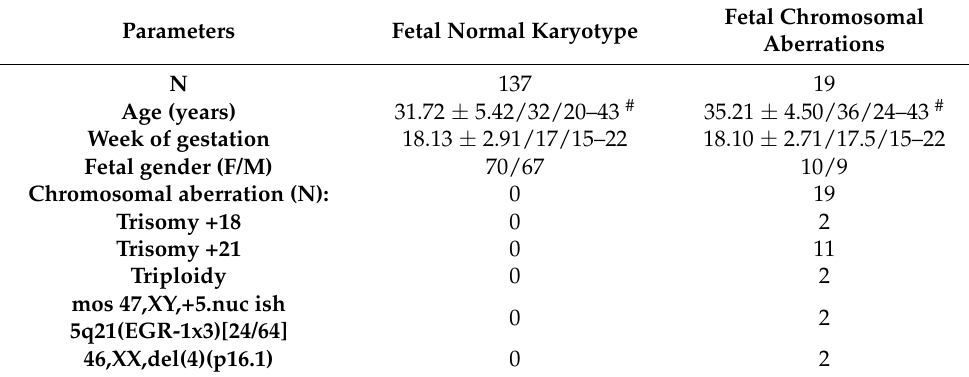
Table 3. Characteristic of the groups (mean ±